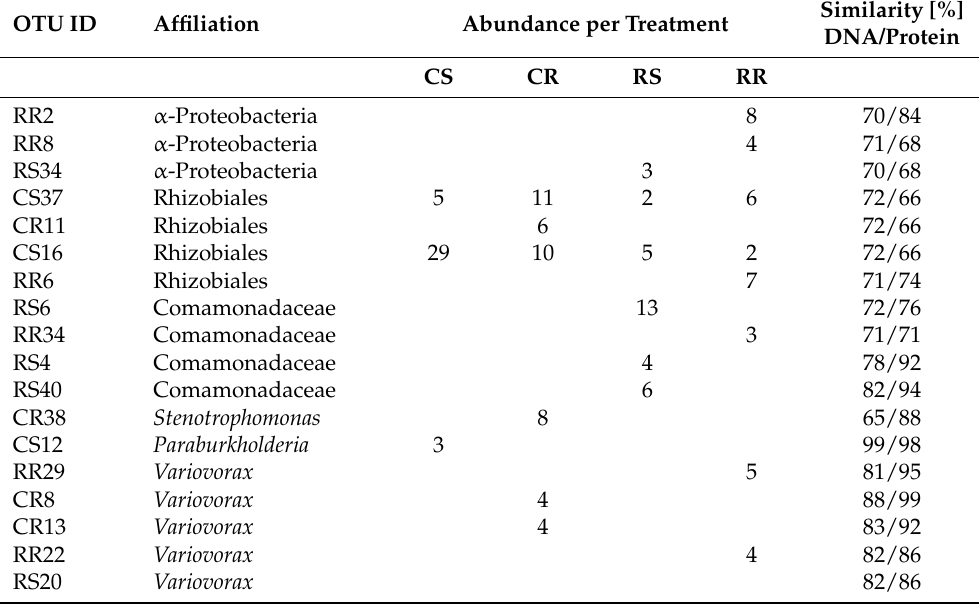
Table 2. Taxonomic assignment of representative desulfonating operational taxonomic units (OTUs) derived from clonal asfA DNA sequence analysis from static hyphosphere cores (CS), rotating hypho- sphere cores (CR), rhizosphere roots from microcosms with static cores (RS) and rhizosphere roots from microcosms with rotating cores (RR). Similarity [%] OTU ID Affiliation Abundance per Treatment DNA/Protein CS CR RS